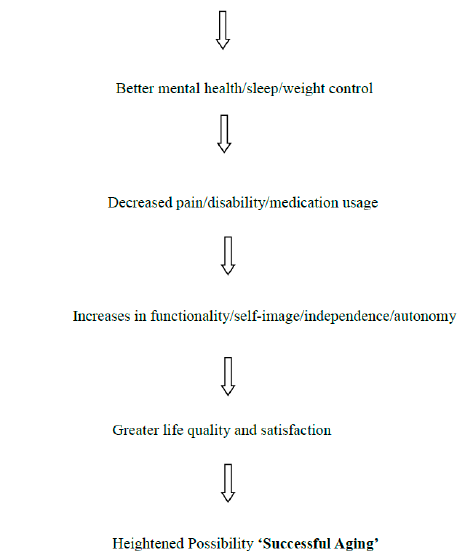
Figure 1. Conceptual model of anticipated outcomes of carefully tailored and titrated management.